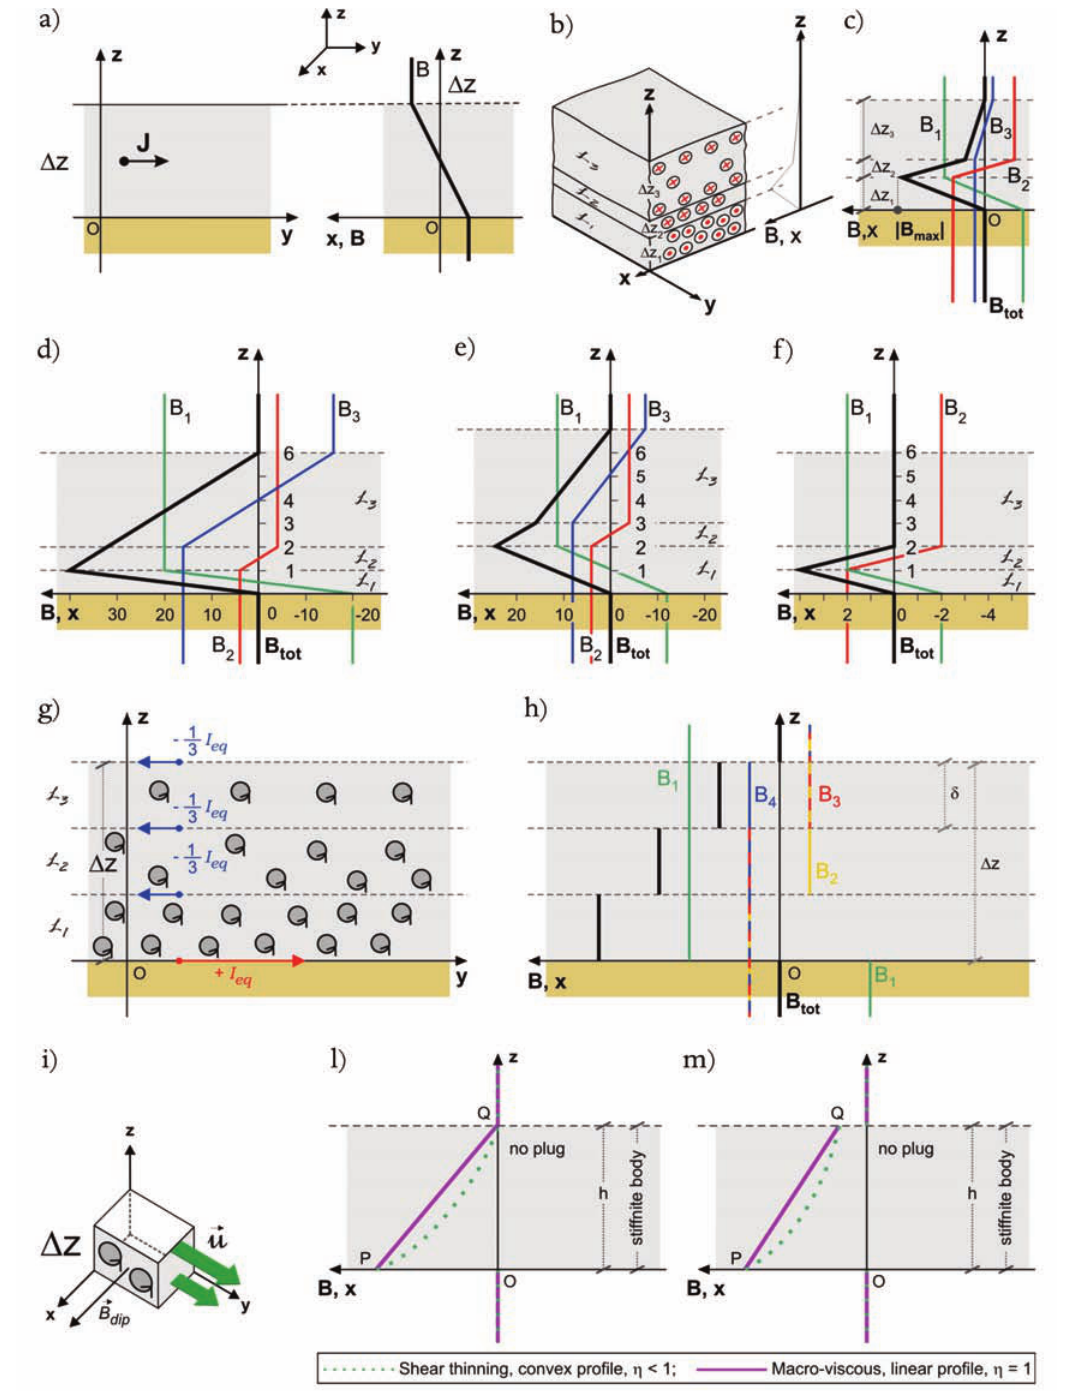
Figure 6. (a) In a conductor (gray) of thickness D z, a current density J (left) creates a magnetic field B (right). (b, c) Conductor with three stacked sheets, from top to bottom: L , L and L , of thicknesses (cid:0) D z , (cid:0) D z and (cid:0) D z , respectively. In L there is a positive (along the positive y -axis) current density J , in 1 2 3 1 2 3 1 1 L 2 and L 3 there are two negative current densities: J 2 and J 3 , respectively. The three current densities create a positive magnetic field (black bold line) directed along the x -axis, with a peak at the interface between L and L . The magnetic field is zero outside the conductors if Equation (7) holds. (d-f) The 1 2 total magnetic field B (bold line) of cases 1, 2 and 3 of Table 2; green (red, blue) line is the magnetic field created by current density J ( J , J respectively) tot 1 2 3 running in L ( L , L , respectively). Numerical values along the x -axis refer to magnetic field and they are multiples of reference units discussed in the main 1 2 3 text and in the captions of Table 2. (g) Three stacked sheets with different densities of magnetic dipole moments. Dipole moments are parallel to the x -axis. They are generated by current loops (small circles with arrows showing current versus ) lying in the y - z planes. Densities decrease bottom to top, but are constant inside each sheet. Red and green arrows are the equivalent currents created by these magnetic dipole moments. (h) Corresponding total magnetic field (bold line) in the plane x - z . Partial magnetic fields B (green), B (yellow), B (red) and B (blue), related to sheets L , L and L , are also shown. (i) 1 2 3 4 1 2 3 Three-dimensional framework of a stiffnite, with the magnetic field B , stiffnite velocity u and magnetic dipoles (current loops) Ambigua . In the illustration, dip the Ambigua sizes are not to scale: in the real world, for example, Ambigua have a thread-like shape. (l, m) Illustrations of the magnetic field in a stiffnite flowing body (gray layer). Dotted and continuum lines show the magnetic field, according to different flow behaviors (see key-legend at the